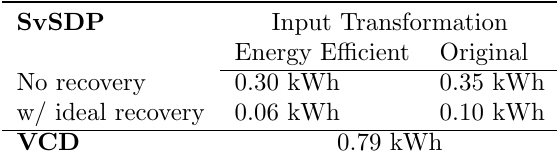
Table 2: Supplied input energy for the investigated knuckle boom crane to perform the test